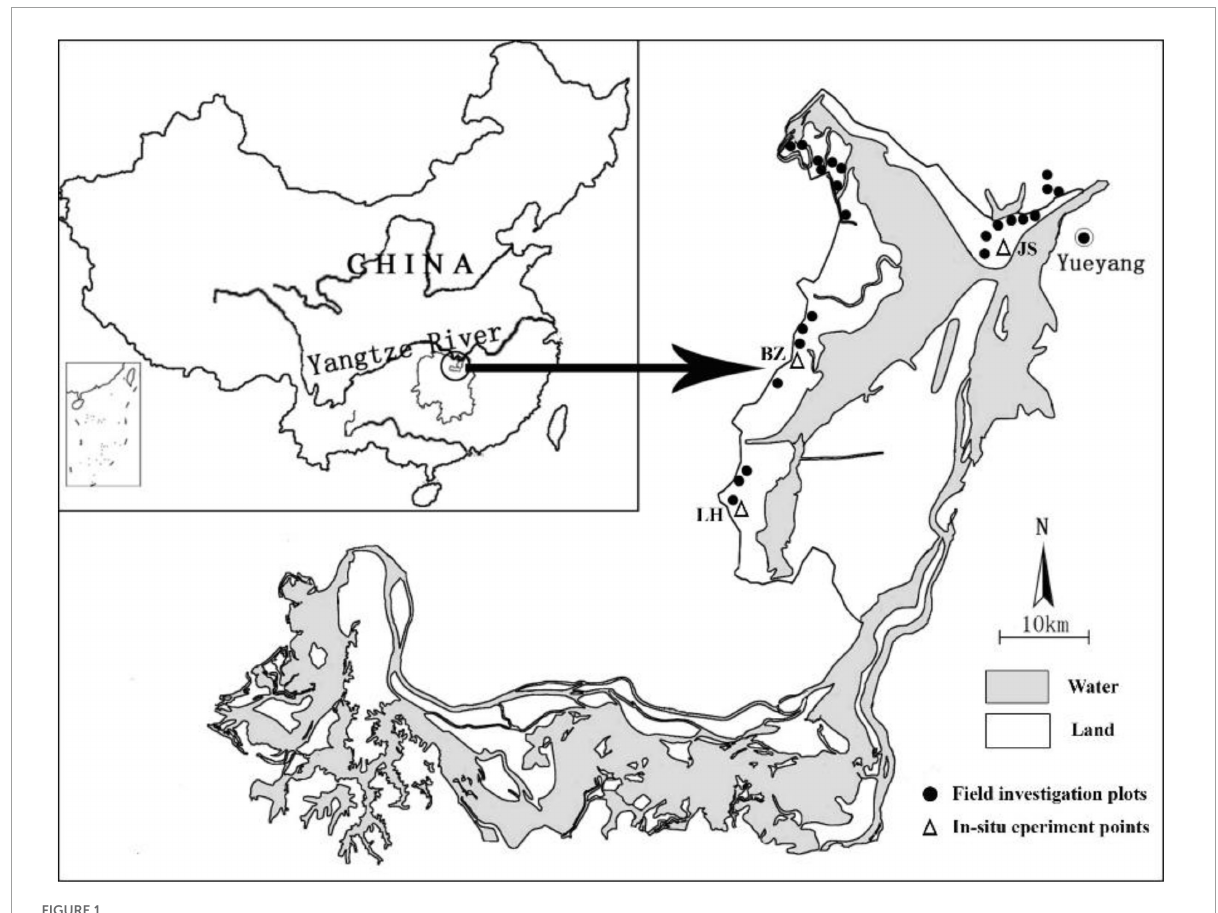
FIGURE1 The field investigation plots (circles) and in situ experiment points (triangles; JS: Junshan; BZ: Beizhouzi; LH: Luhu) in the Dongting Lake